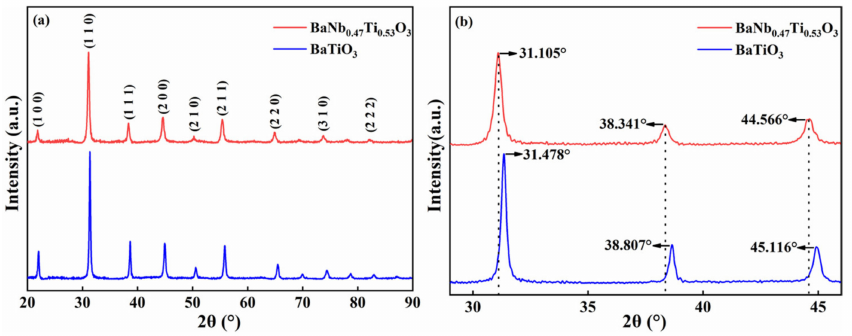
Figure 2. XRD pattern of electrochemically synthesized powder ( a ) and its partially enlarged schematic diagram ( b